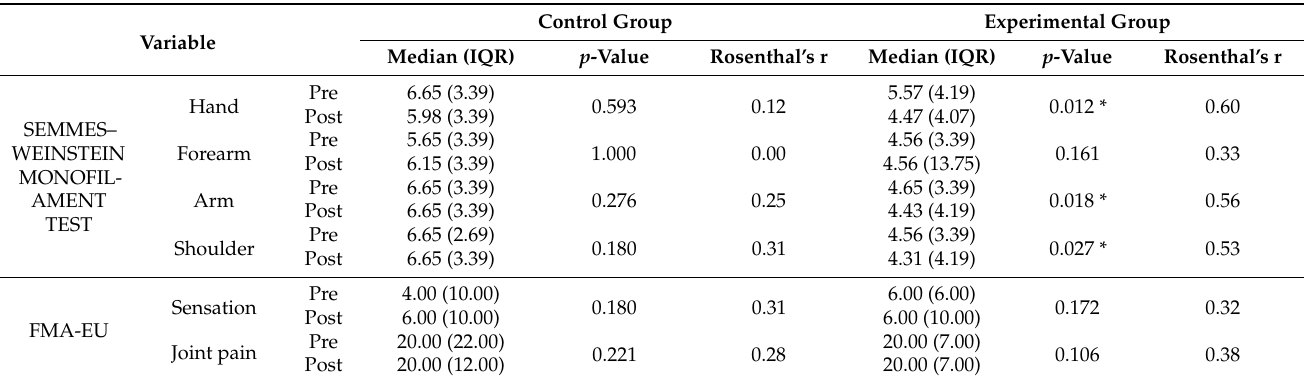
Table 2. Sensitive and pain assessment pre- and post-treatment in control and intervention group. Intragroup comparison.